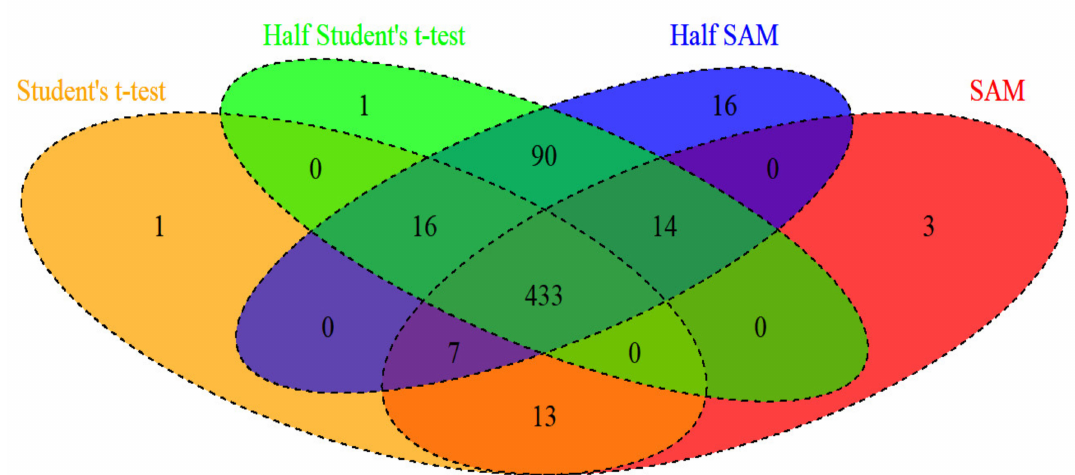
Figure 5. Venn diagram of differentially expressed genes detected by the various test methods in colon cancer data at a significance level of